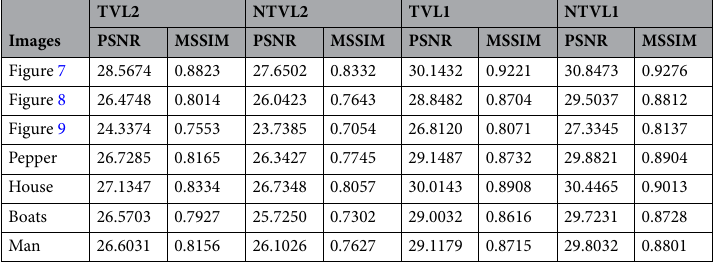
Table 3. PSNR and MSSIM for TVL2, NTVL2, TVL1 and NTVL1